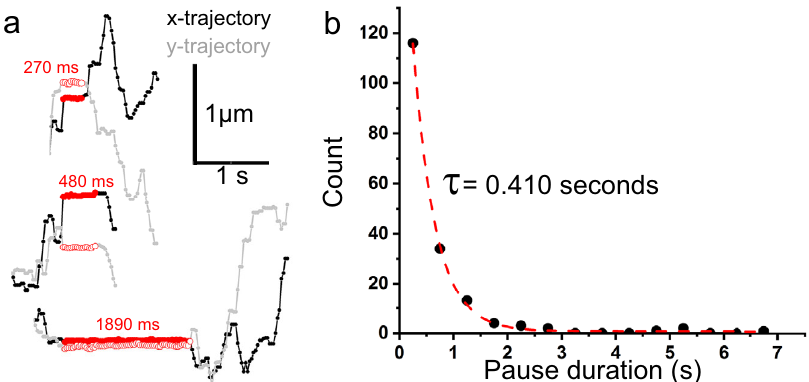
Fig. 4 P-selectin undergoes transient binding interactions during diffusion at steady-state. a Examples of x-y trajectories for AK6-Cy3B-labeled P-selectin under steady-state conditions. Regions marked in red, highlight brief pauses in motion. b Distribution of pause durations and lifetime, τ (176 events, bin width 0.5